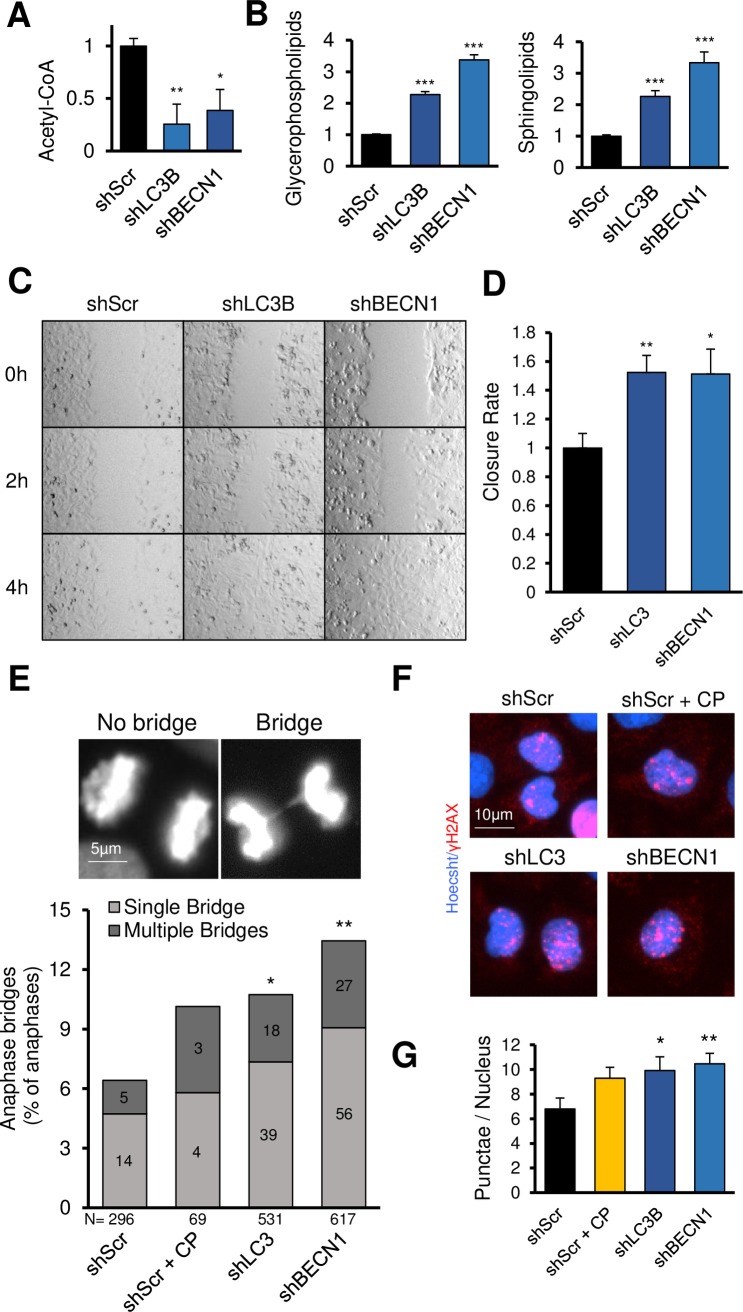
Knockdown of LC3B or BECN1 increases oncogenic phenotypes.A-B, SKOV3 cells transduced by the indicated lentivirus were assayed by metabolomics. Quantitation of the indicated metabolites is shown. C, Confluent SKOV3 cells were tested for migration rates using a scratch-wound assay. D, Quantitation of three independent wound closure experiments. E, Dividing SKOV3 cells were imaged for DNA content, blinded, and scored for anaphase bridge formation. CP denotes cisplatin use. N is the number of anaphases analyzed from three independent assays. F, SKOV3 cells were imaged for γH2AX puncta. N > 900 cells per condition from two independent assays. G, Quantitation of (F). * indicates P ≤ 0.05, **P ≤ 0.01, ***P ≤ 0.001.